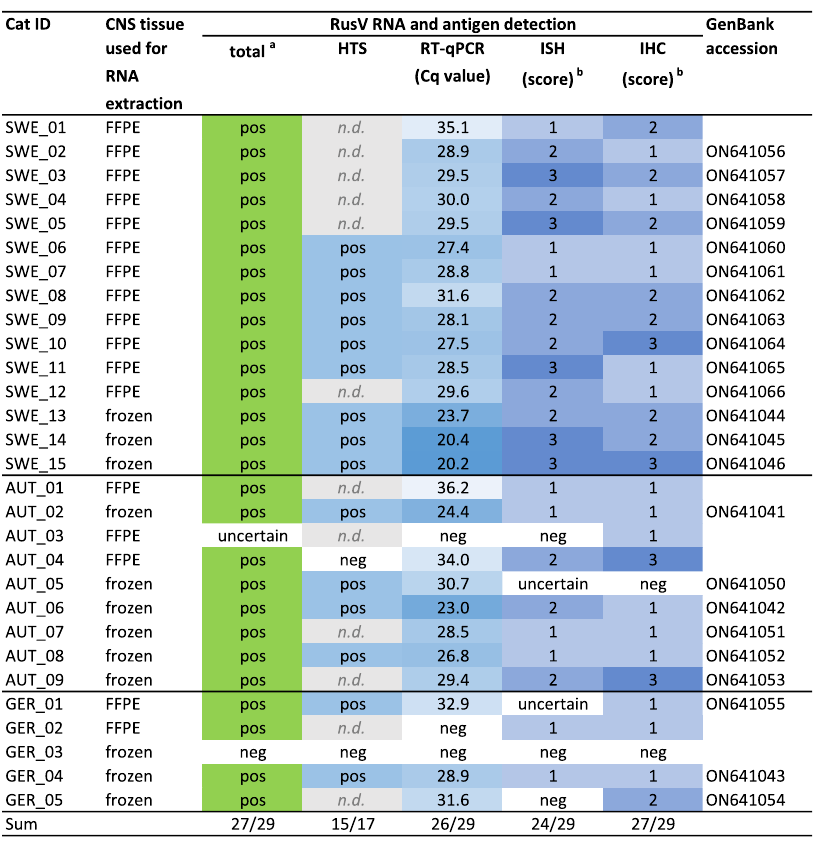
indicates positivity for the detection of RusV RNA or antigen in an individual test. The intensity of the colour semiquantitatively re fl ects the strength of the signal of the respective assay. The scoring of IHC and RNAscope ISH signals is described in Table 2. CNS central nervous system, FFPE formalin- fi xed paraf fi n-embedded, HTS high-throughput sequencing followed by metagenomic analysis, Cq cycle of quanti fi cation, ISH in situ hybridization using RNAscope, IHC immunohistochem- istry, pos positive, neg negative, n.d. not